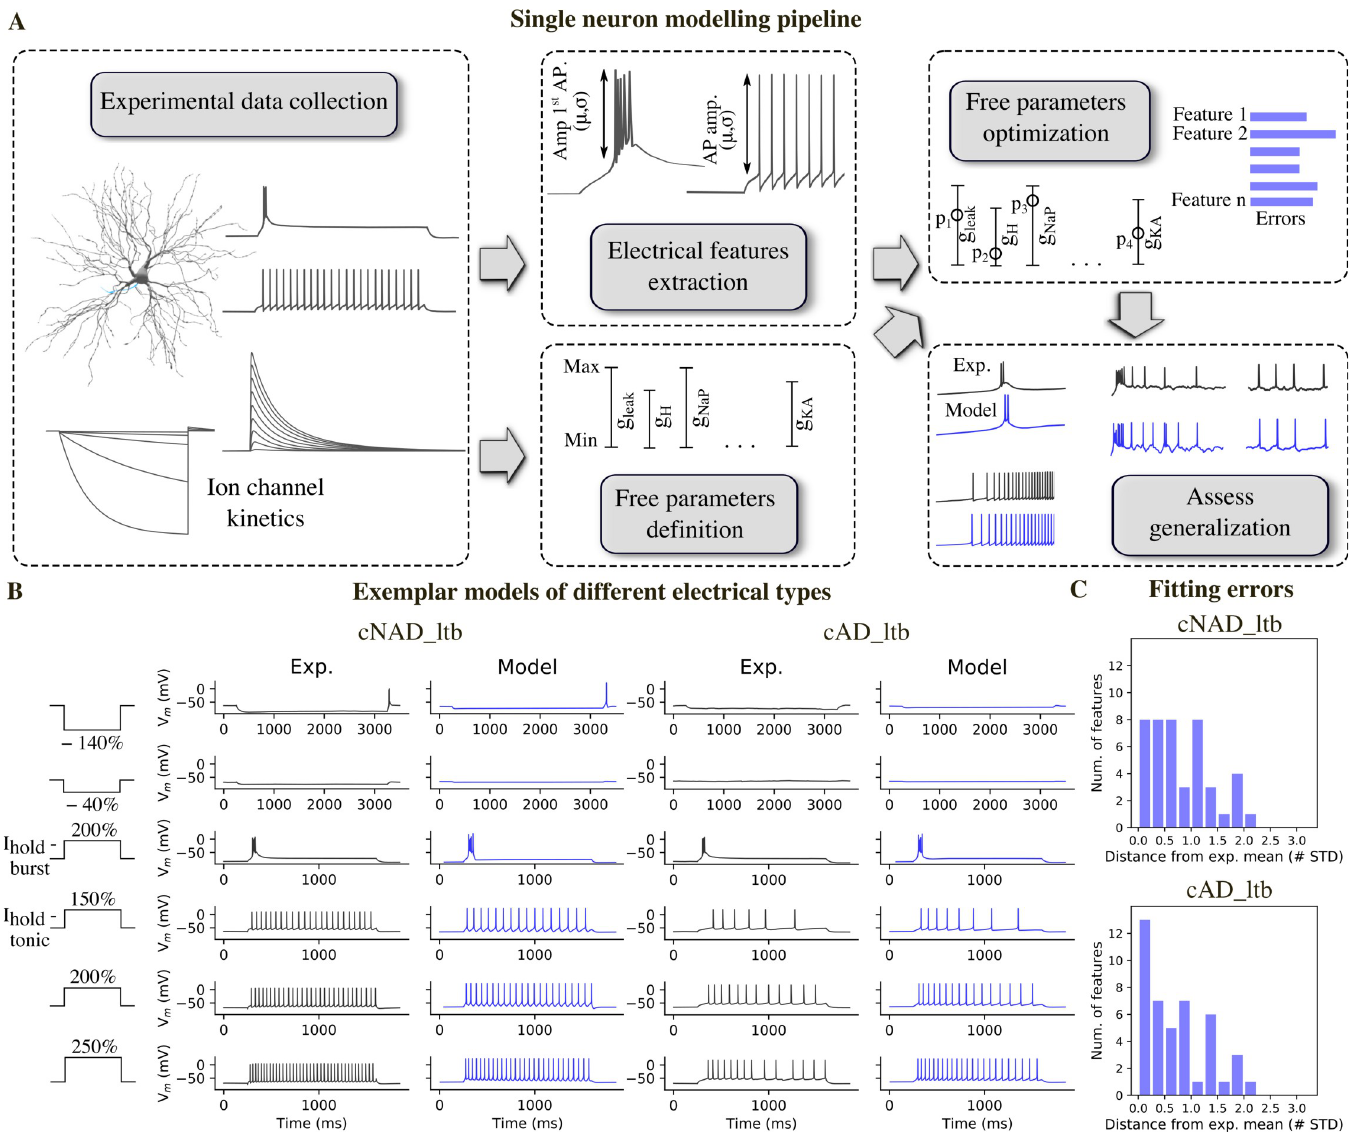
Fig 4. Models of different TC e-types and their fitting errors. (A) Single neuron modelling pipeline. (B) Experimental and model voltage responses to a variety of stimuli pattern used during the optimization of cNAD_ltb and cAD_ltb e-types. (C) Feature errors of the models shown in (B) reported as deviation from the experimental mean. The models are compared with the mean of features shown in Fig 3. Note that the models shown in B are fitted in order to reproduce the mean firing properties, not only a specific experimental recording. See S2 Fig for a complete list of fitting errors.